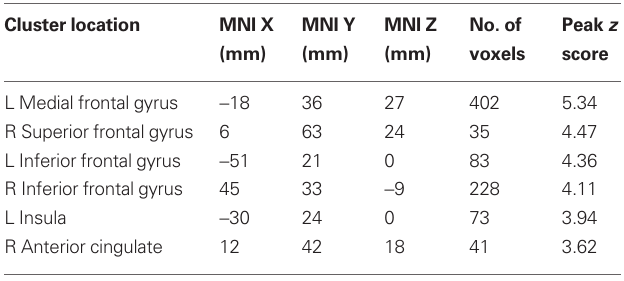
Figure 5 | BOLD response reflecting average participant behavior. (A) Activation in ventral striatum covaried with herd influence (peak at 6, 15, − 6; p < 0.05 FDR, small volume correction; z = 3.7). This corresponds to the change in behavior as a function of human social information minus the change in behavior as a function of chimp information. (B) Correlation of first-level parameter estimates from individualized herd influence contrasts